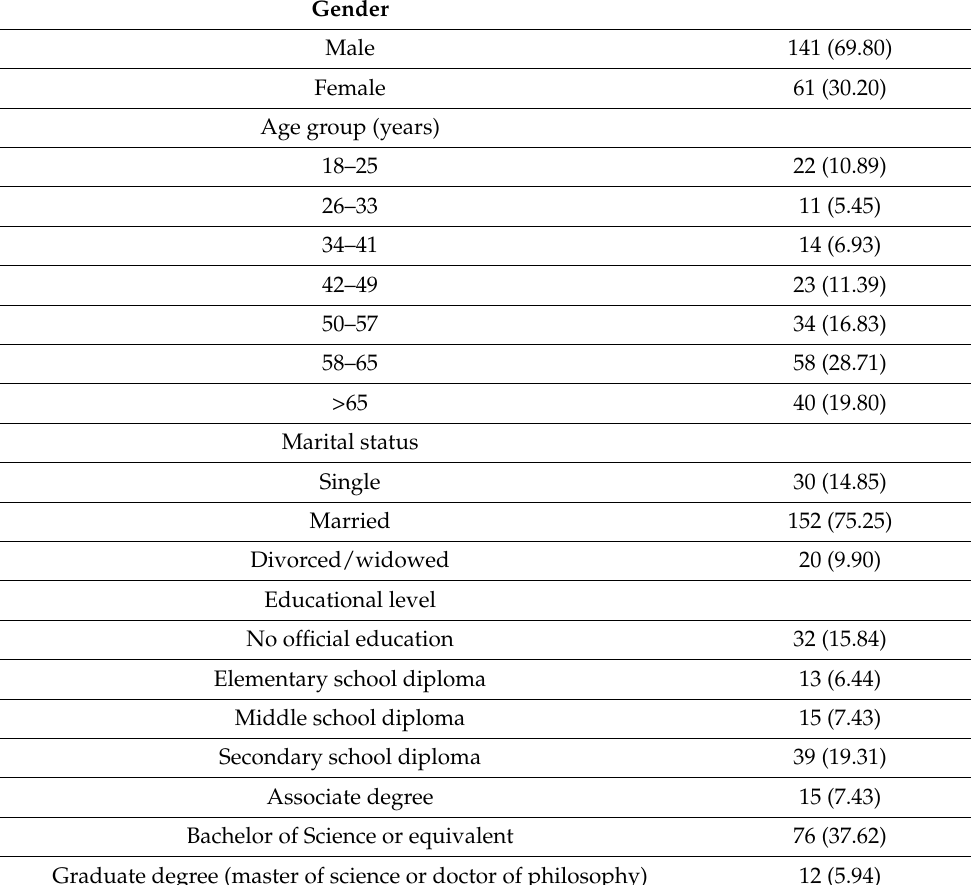
Table 1. Study participants’ sociodemographic characteristics ( n =